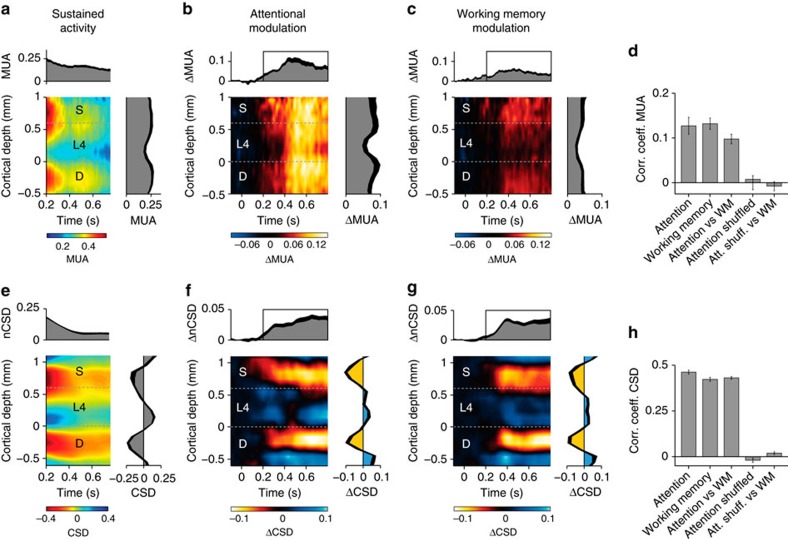
The laminar profile of selective attention and working memory.(a) Laminar pattern of spiking activity in the epoch after the peak response. (b,c) The attentional modulation (b) and working memory effect (c) on spiking activity across the depth of the cortex, which is the difference in activity elicited by the (memory of) the target and the distractor curve (red minus blue traces in Fig. 2b,e). Graphs on the right and above show the averages across layers and across the modulation period (black rectangles in the upper graphs; 200–750 ms after stimulus onset), respectively. The thick black traces represent s.e.m. (d) Consistency of the laminar MUA profile as assessed with an analysis of correlations between penetrations and between the attention and working memory conditions. Also shown are controls when the data are shuffled. Error bars indicate s.e.m. (e) Average CSD during the episode when the peak response has subsided. The average laminar CSD profile is plotted on the right. The upper panel shows the inner product of this profile with the CSD at the different time points (nCSD). (f,g) Average difference in CSD between target and distractor curve. (h) Analysis of the consistency of the laminar CSD profile across penetrations by computing pair-wise correlations. n=37 penetrations in all plots.